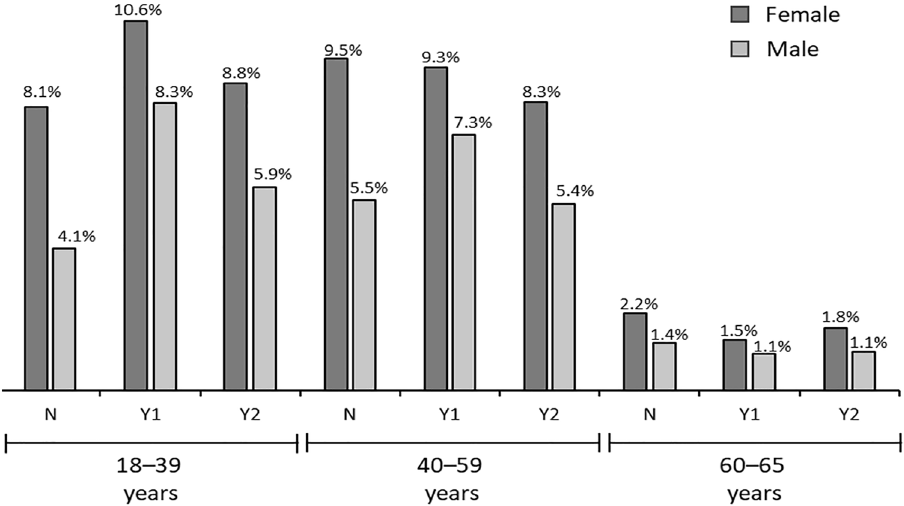
Figure 6. Stratification of potential BoPD cohort by age group, gender and diagnosis history on bipolar and suicidal or intentional self-harm behaviour. N: No diagnosis code of bipolar or suicidal/intentional self-harm and had ≥ 3 categories in mental disorder categories in Table 2; Y1: Had diagnosis code of bipolar or suicidal/ intentional self-harm and had ≥ 3 categories in mental disorder categories in Table 2 (including bipolar or suicidal/intentional self-harm); Y2: Had diagnosis code of bipolar or suicidal/intentional self-harm but had < 3 categories in mental disorder categories in Table 2 (including bipolar or suicidal/intentional self-harm).